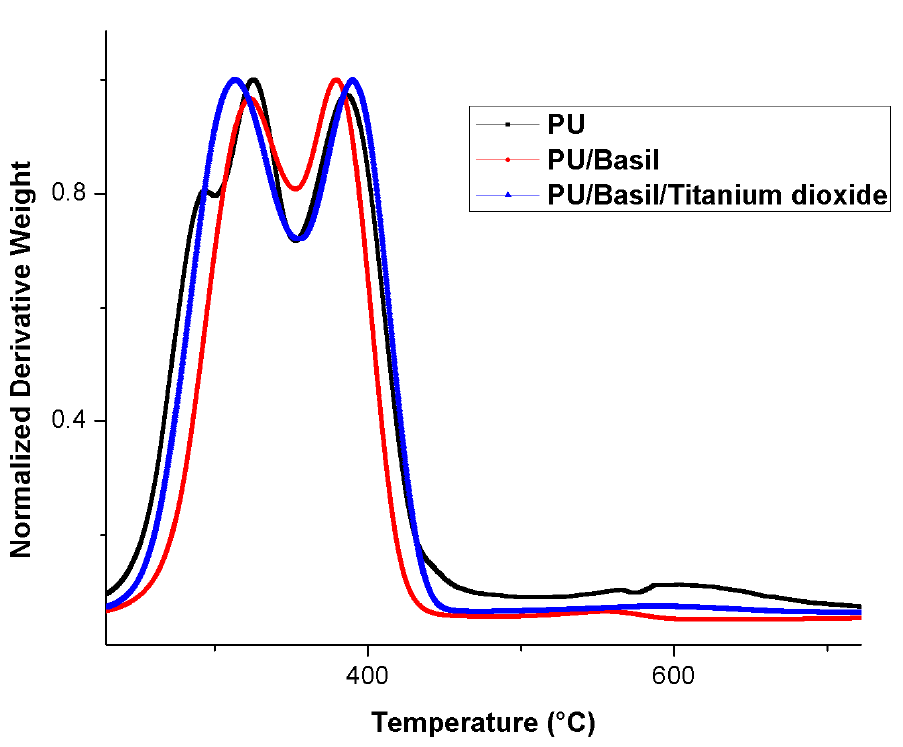
Figure 9. Weight residue of PU, PU/BASIL and PU/BASIL/TiO 2.